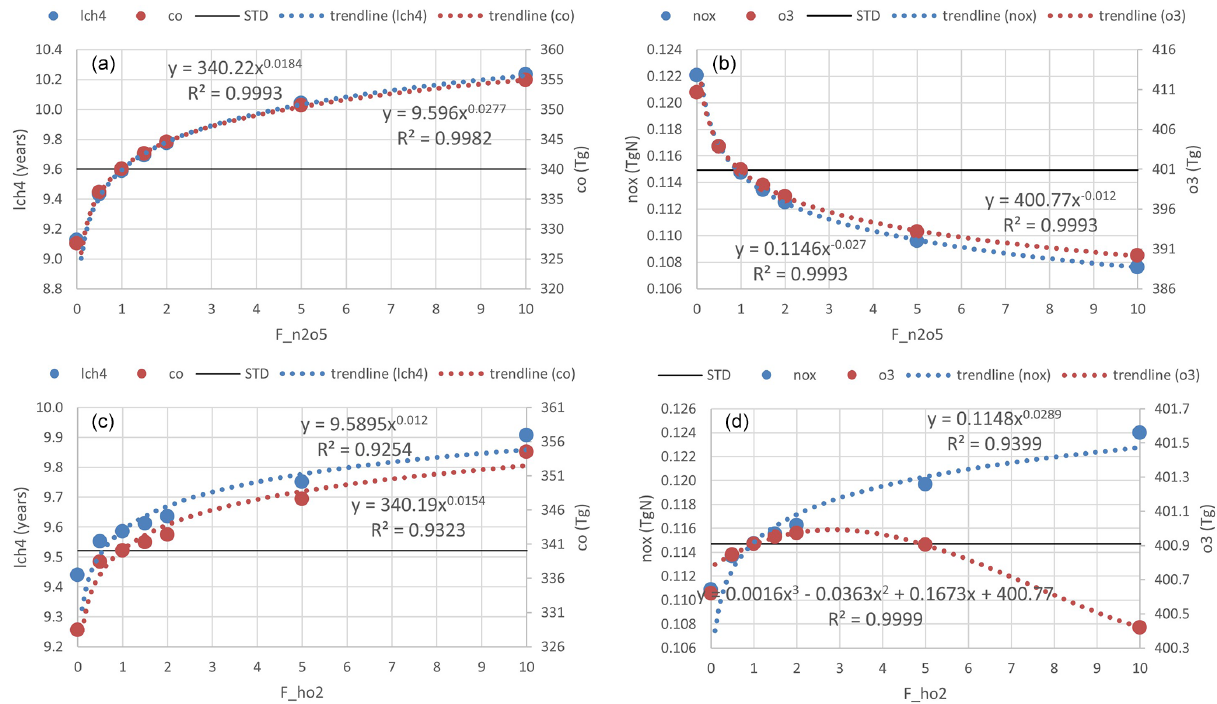
Figure 15. Trend lines for the sensitivity of HR(N 2 O 5 ) (a, b) and HR(HO 2 ) effects (c, d) , with uptake rates shown. Panels (a) and (c) show the CH 4 lifetime (blue) and tropospheric abundance of CO (red). Panels (b) and (d) show tropospheric abundances of NO x (blue) and O 3